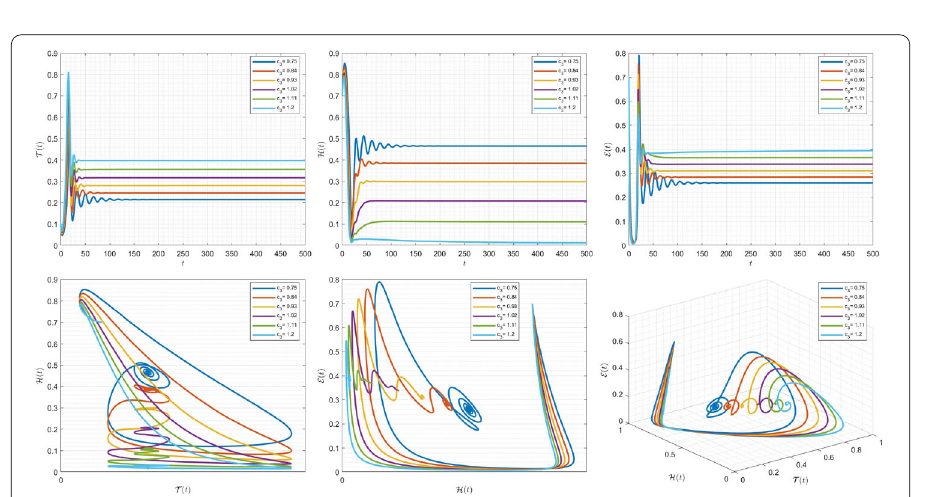
Figure 20 Simulations for solving (43) using (59) along with ( T (0), H (0), E (0)) = (0.3,0.7,0.7) and α = 0.98 for different c